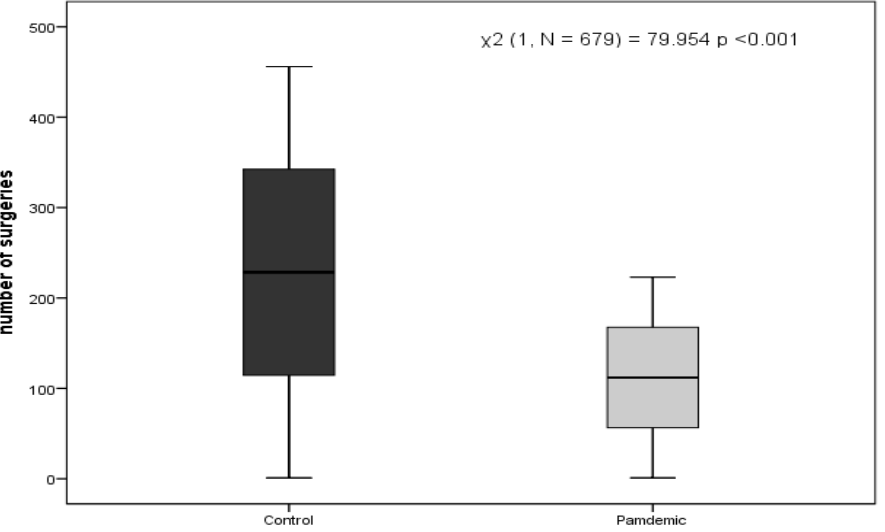
Figure 1. Box plot comparing the number of surgeries during the control and pandemic periods. Three hundred seventy-six (55.4%) of the patients were males, 246 (65.4%) of whom underwent surgery during the control period and 130 (34.6%) during the pandemic pe ‐ riod. In addition, 210 (69.3%) of female patients underwent surgery during the control period and 93 (29.7%) during the pandemic period. The mean age of our sample was 50.6 ± 17.5;for these data, the independent samples t ‐ test between the control (Mdn = 52) and pandemic periods (Mdn = 50) was not significant, p ‐ value of 0.171. Finally, mortality rates